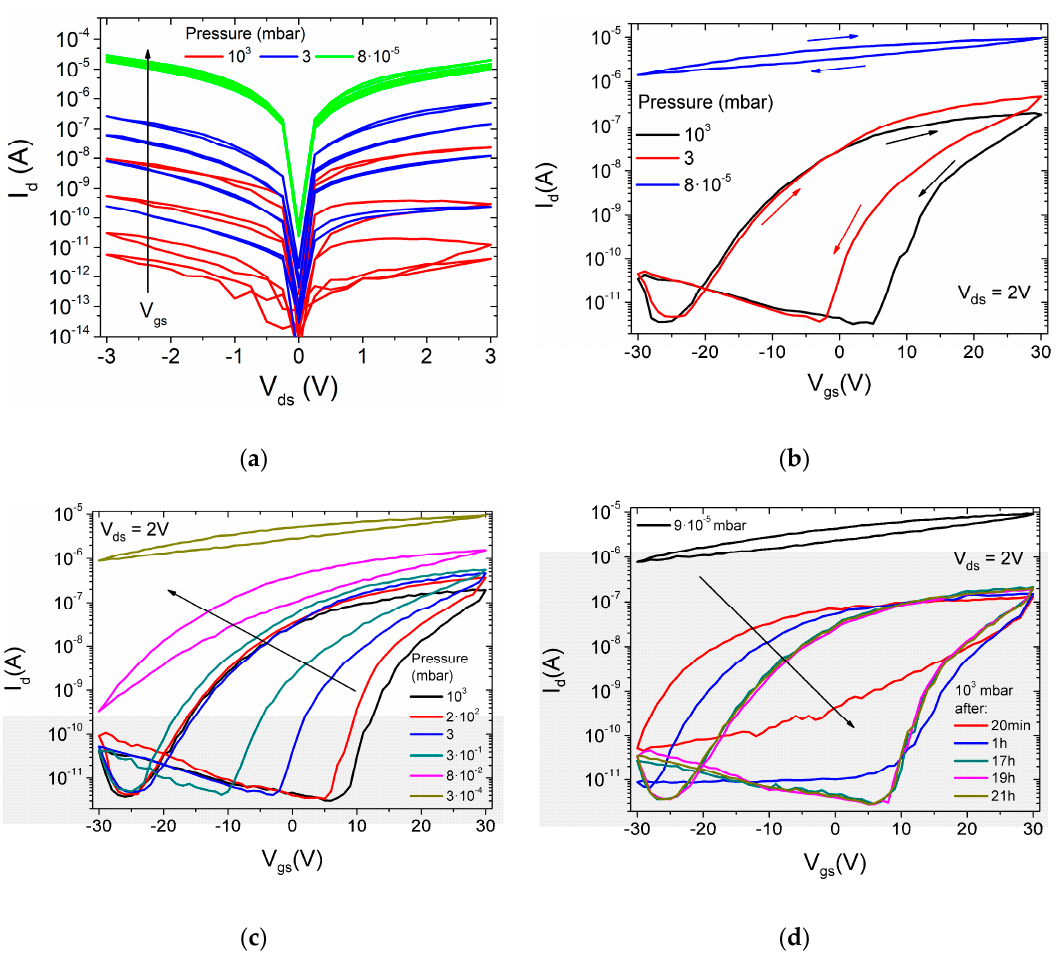
Figure 3. ( a ) Output curves at different gate voltages (V gs = 0, 10, 20, 30 V) for three different air pressures (atmospheric, 3 mbar, 8 × 10 − 5 mbar). ( b ) Transfer curves for three different air pressures (atmospheric, 3 mbar, 8 × 10 − 5 mbar). The arrows show the direction of voltage gate sweeping starting from 30 V. Transfer characteristics ( c ) for lowering pressure, and ( d ) at different times after reaching the room